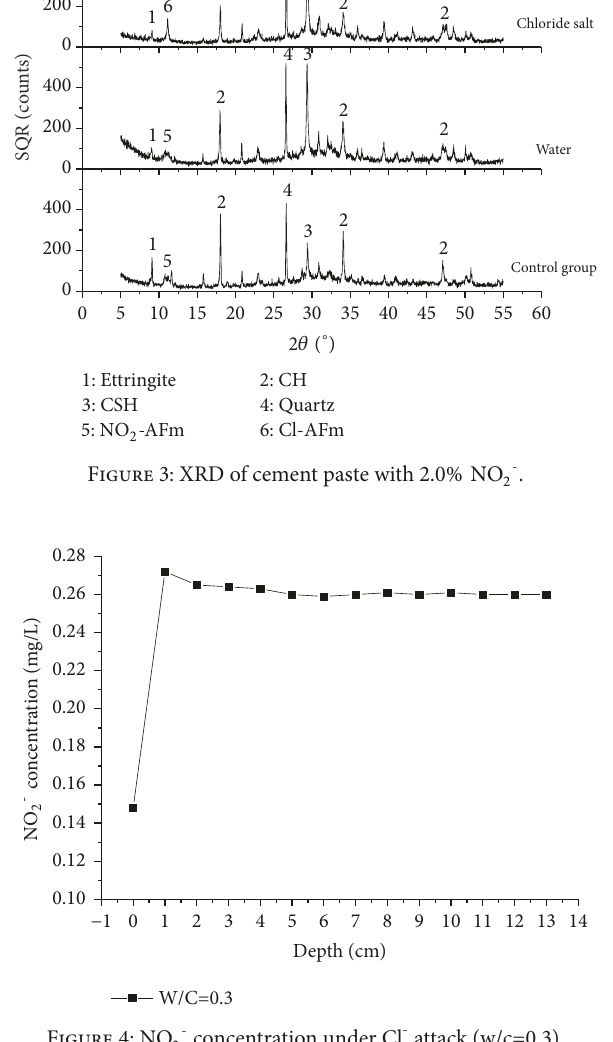
Figure 4: NO 2 - concentration under Cl - attack (w/c=0.3).